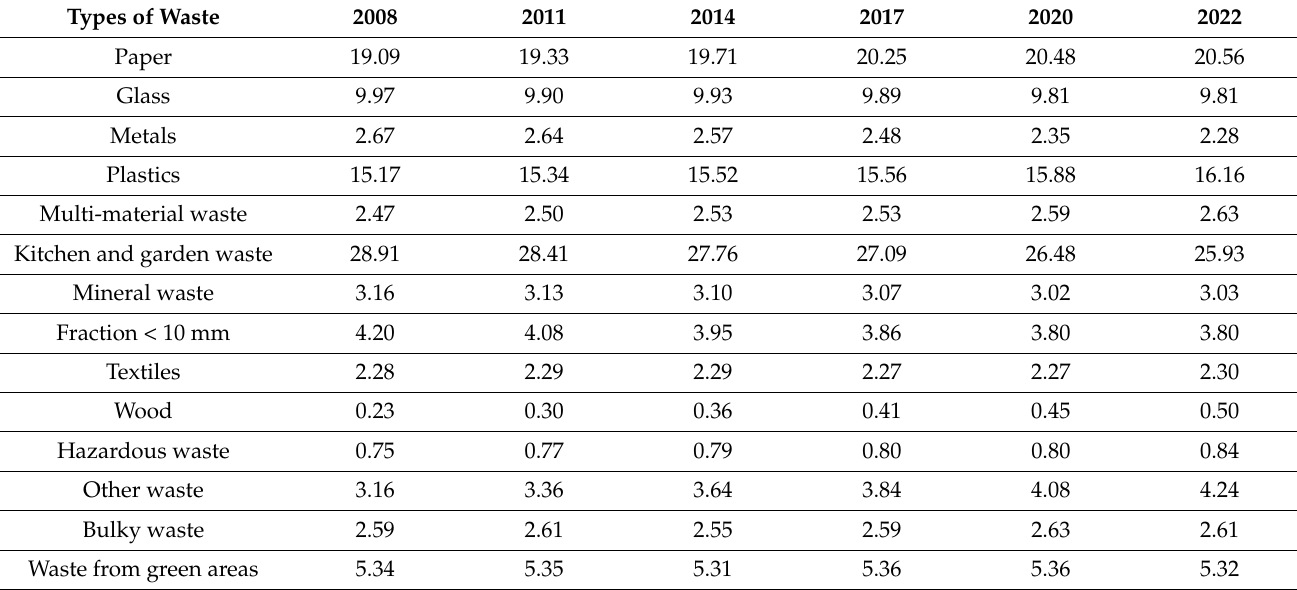
Table 2. Projected changes in the morphological composition of municipal waste from large cities (%) [63].